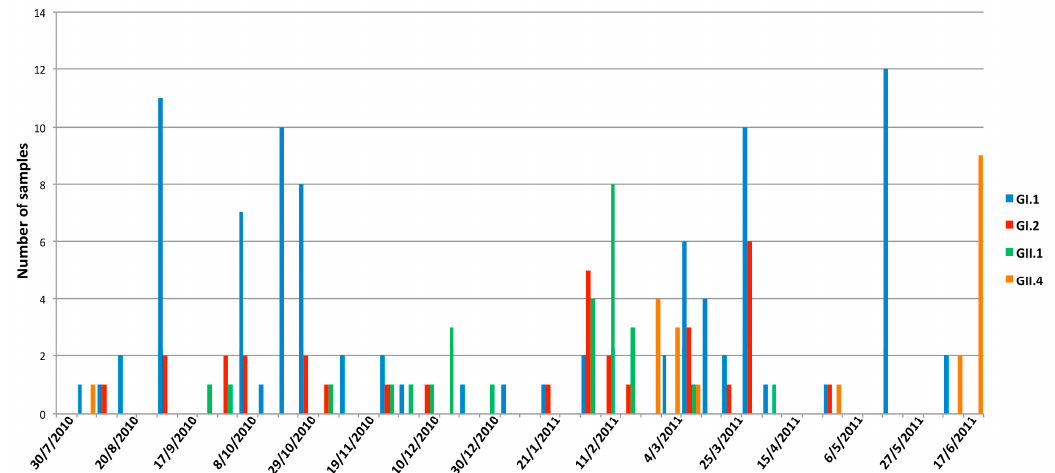
Figure 6. Weekly temporal distribution of the most prevalent SaV genotypes. Table 1. Genetic distribution of SaV in the different age groups (years old).